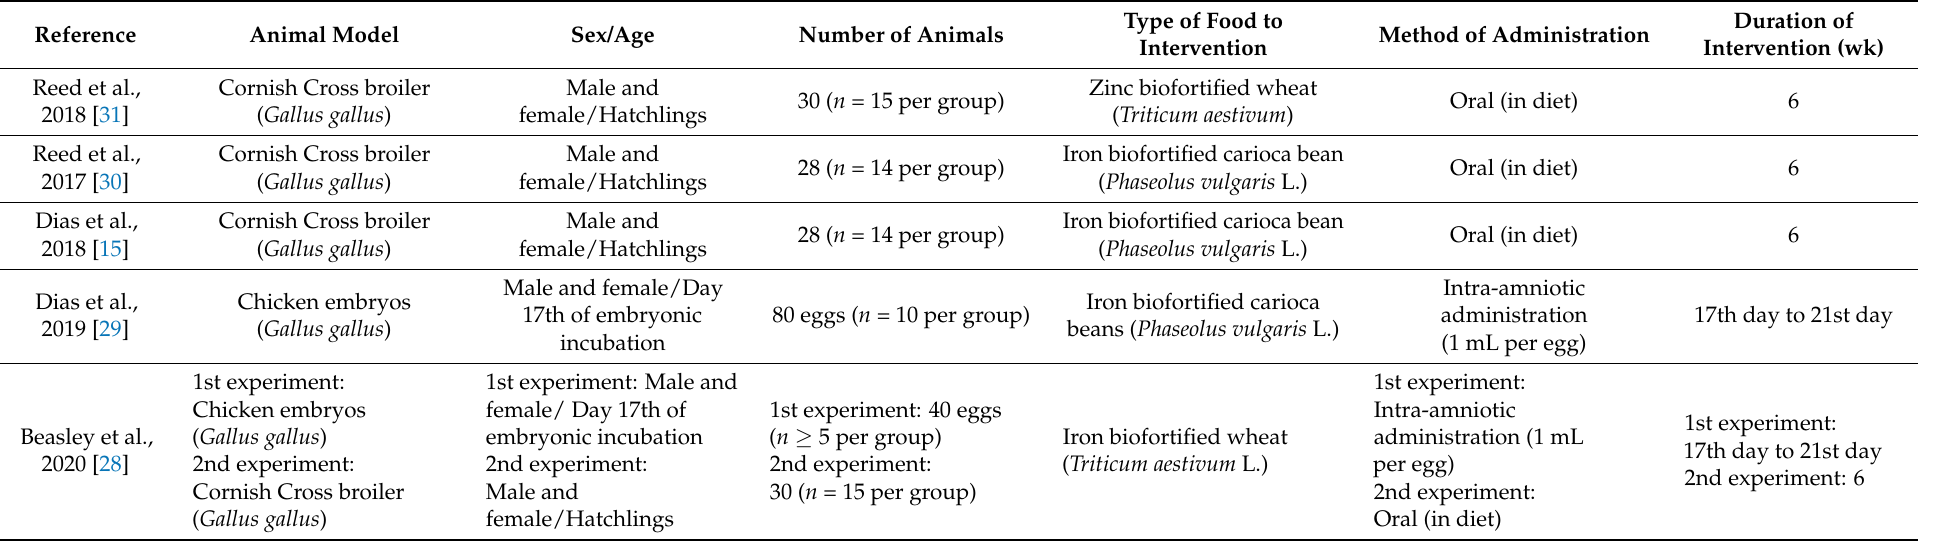
Table 2. Characteristics of the eligible studies assessed for Fe and Zn biofortified foods in the gut microbiota modulation.